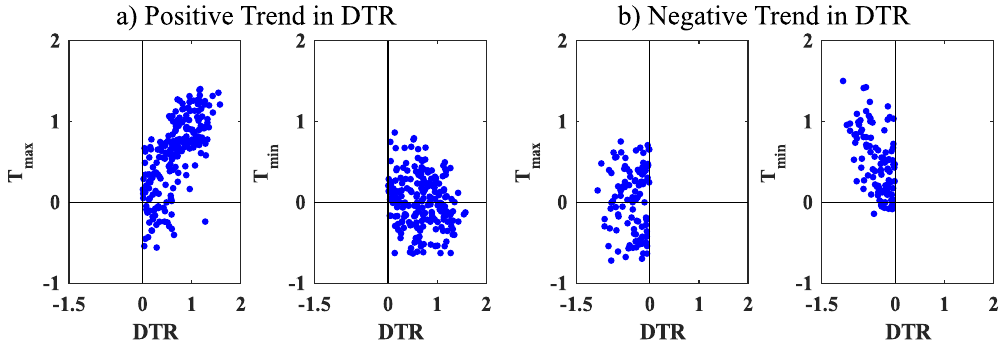
Figure 4. Scatter plot of Ensemble Empirical Mode Decomposition trend in a) positive trend of DTR and T max ( T min ) and b) negative trend of DTR and T max ( T min ) for the last time window (1951–2010). Unit is in °C. The maps were generated using the software MATLAB (version 2014b) http://www.mathworks.com/products/ matlab/.